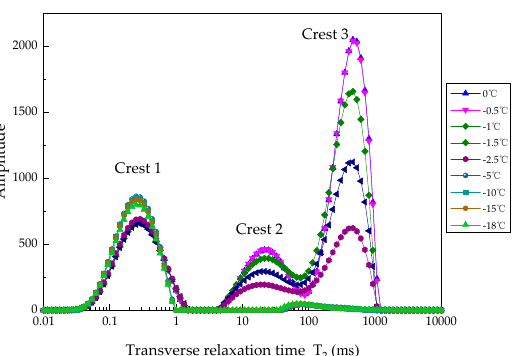
Figure 2. Variation of T 2 distribution curve during the freezing of the saturated sand.